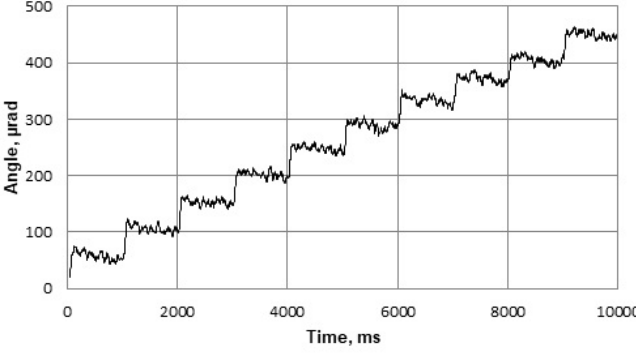
Figure 17. Measured stepped rotation of the